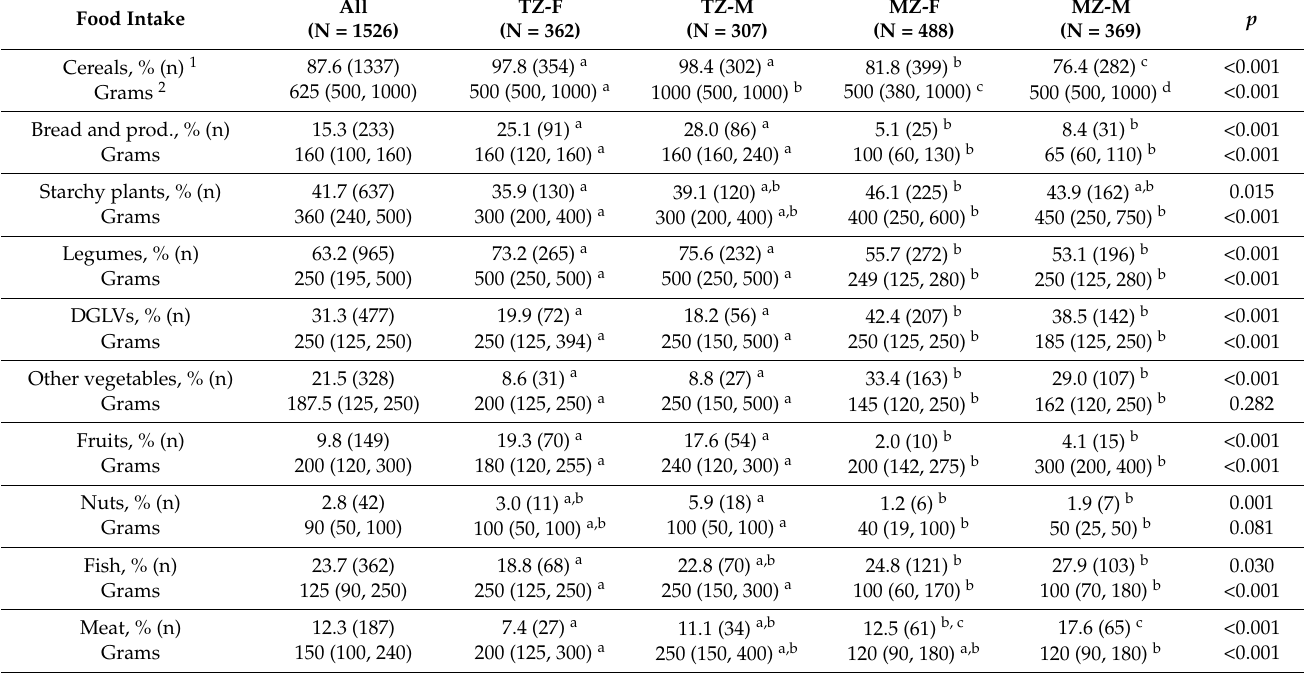
Table 3. Frequency and amount of consumed food groups (in grams) by sex and